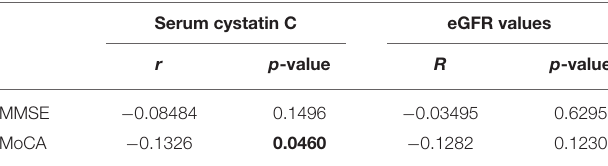
TABLE 2 | Correlations of serum cystatin C levels and eGFR values with cognitive